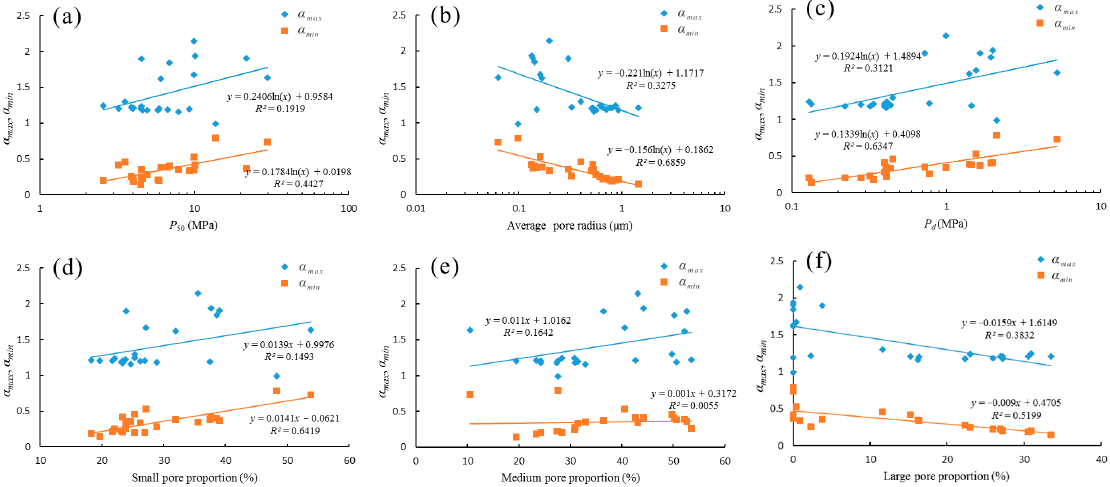
Figure 10. The cross plots between multifractal parameters and MICP parameters. ( a ) the cross plots between α max , α min and P 50 ; ( b ) the cross plots between α max , α min and average pore radius; ( c ) the cross plots between α max , α min and P d ; ( d ) the cross plots between α max , α min and small pore proportion; ( e ) the cross plots between α max , α min and medium pore proportion; ( f ) the cross plots between α max , α min and large pore proportion; ( g ) the cross plots between D max , D min and P 50 ; ( h ) the cross plots between D max , D min and average pore radius; ( i ) the cross plots between D max , D min and P d ; ( j ) the cross plots between D max , D min and small pore proportion; ( k ) the cross plots between D max , D min and medium pore proportion; ( l ) the cross plots between D max , D min and large pore proportion.